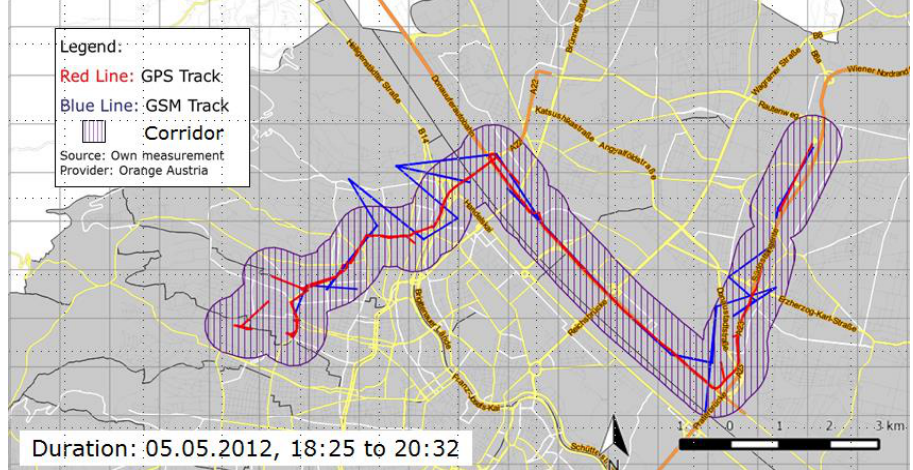
Figure 5. Comparison between a GPS track (red) and the corresponding cell tower locations (blue) of a trip of a test user from the 22nd district to the 18th district in Vienna. The purple striped area depicts the accuracy corridor of 1 km.